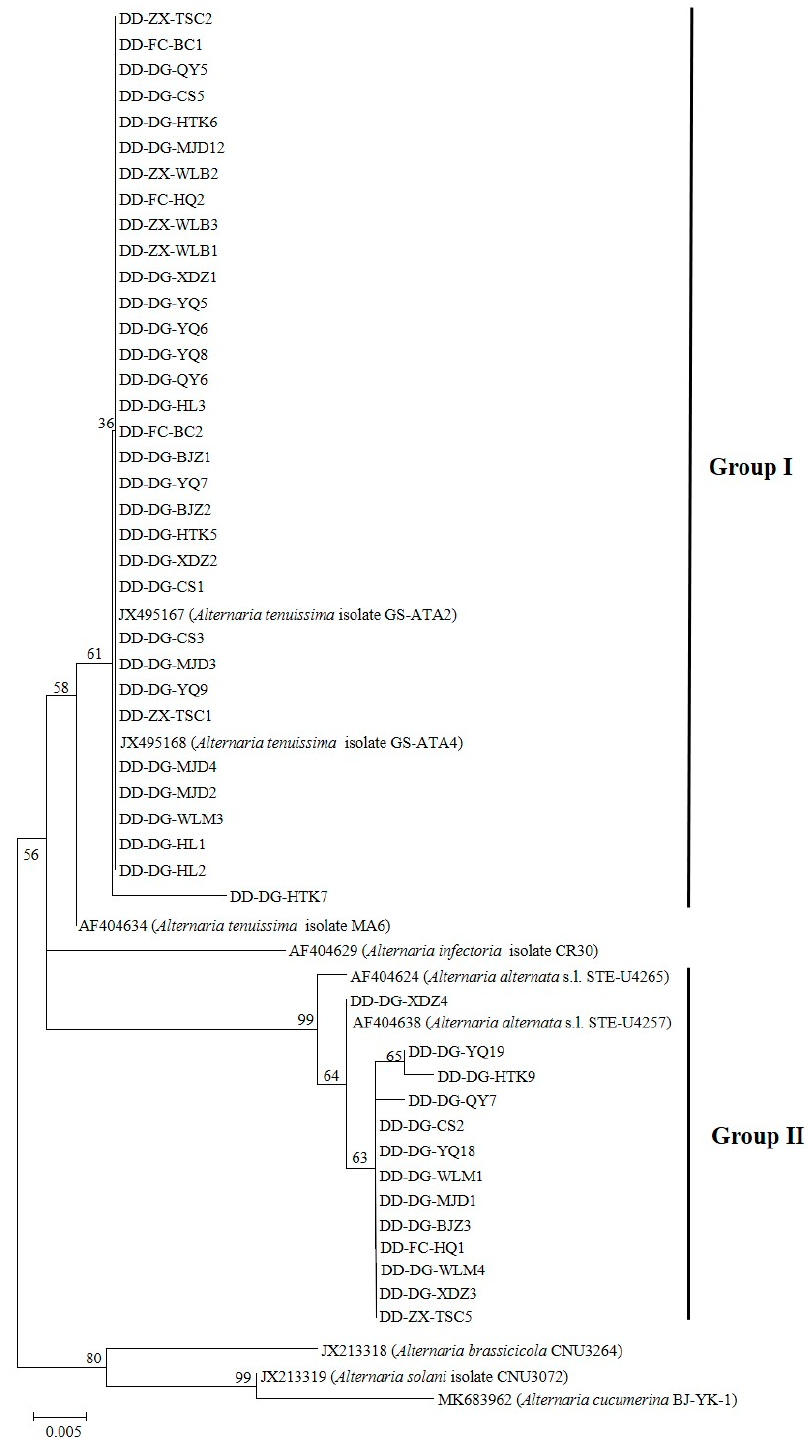
Figure 3. Phylogenetic tree based on the partial coding sequences of the histone 3 gene of the 46 Alternaria isolates used in pathogenicity and the 9 reference sequences published in the NCBI library. The algorithm is based on the Maximum Likelihood estimate. Bootstrap values with 1000 repli- cations were found at nodes on the phylogenetic tree, which identified the A. brassicicola CNU3264, A. solani isolate CNU3072, A. cucumerina BJ-YK-1, and the A. infectoria isolate CR30 (AF404634) as